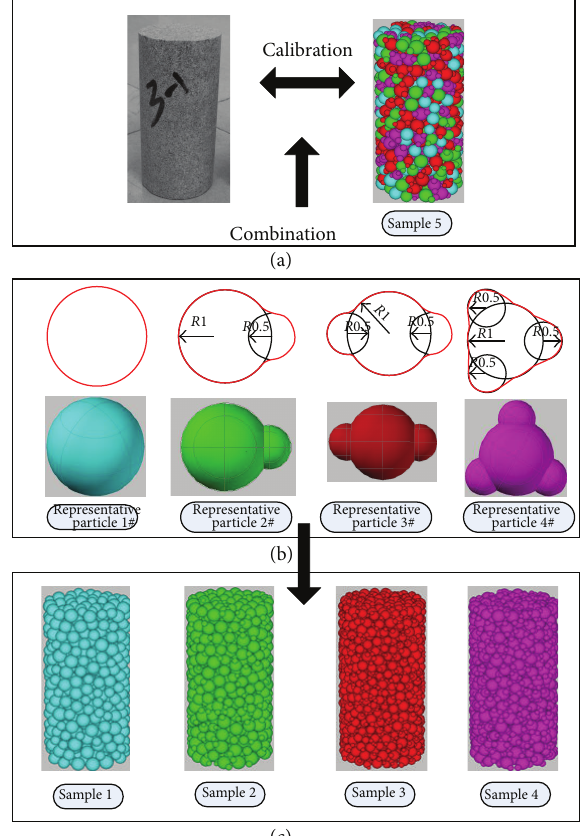
Figure 2: The representative particles and